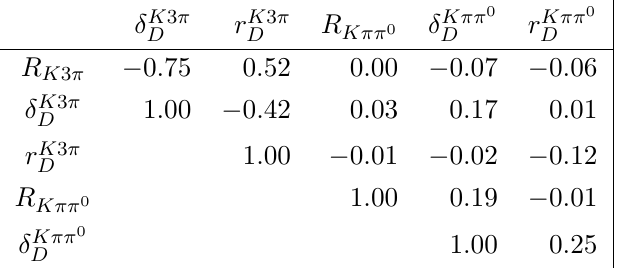
Figure 15 . Scans of ∆ χ 2 in the BESIII and CLEO-c global fit in the ( R K 3 π , δ K 3 π ) parameter space, showing the ∆ χ 2 =2.30, 6.18, 11.83 intervals, which corresponds to the δ Kππ 0 D 68 . 3% , 95 . 4% and 99 . 7% CLs in the two-dimensional parameter space.